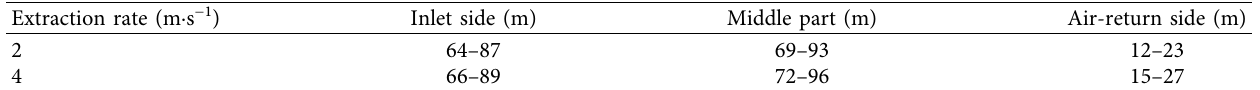
Table 5: Distribution of spontaneous combustion zone in goaf with different extraction rates ( y � 10m). Extraction rate (m · s − 1 ) Inlet side (m) Middle part